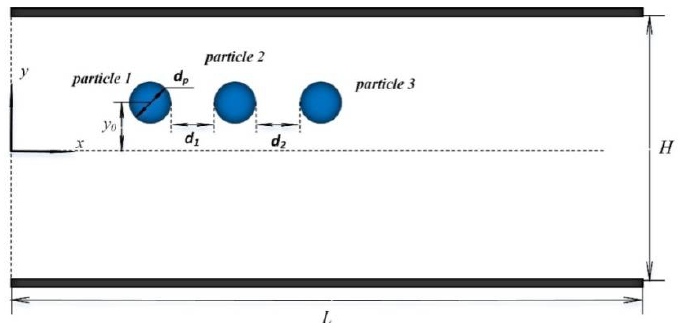
Figure 2. Schematic diagram of three particles in a pressure-driven flow of viscoelastic fluid.